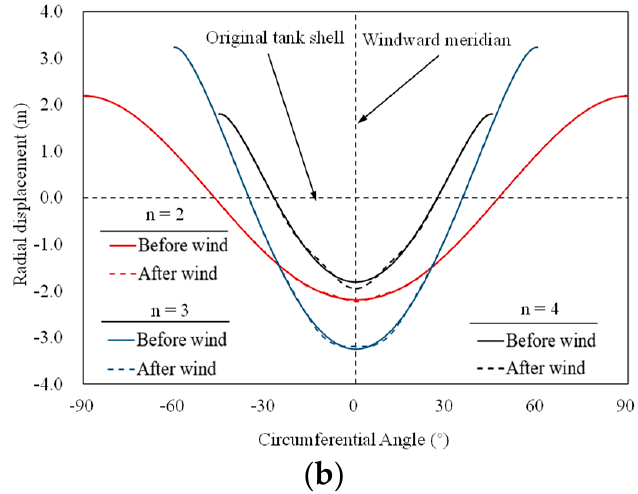
Figure 15. Radial displacement of the tank shell: ( a ) radial displacement at windward meridian along the height of the tank shell; ( b ) radial displacement at the top of the tank shell along the angle of circumference.